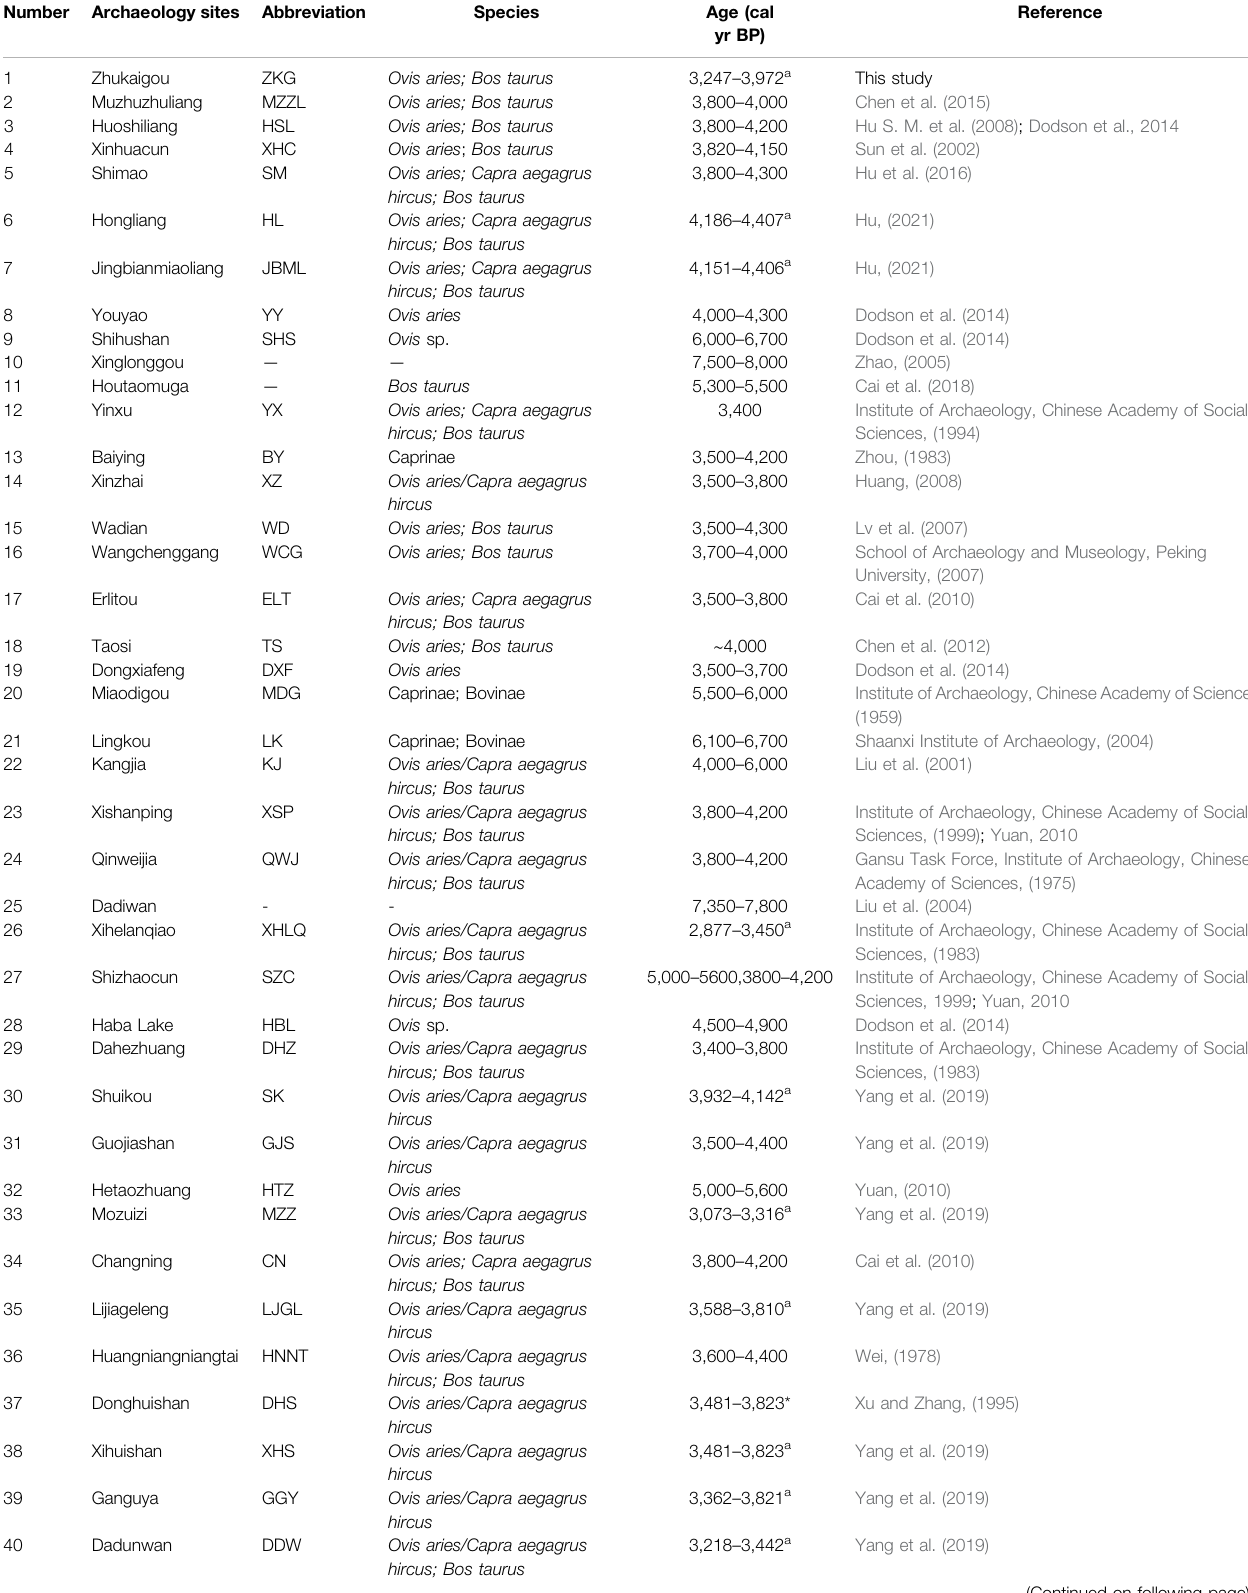
TABLE 1 | The sites names represented by numbers in Figure 1 and their abbreviations in this study. Number Archaeology sites